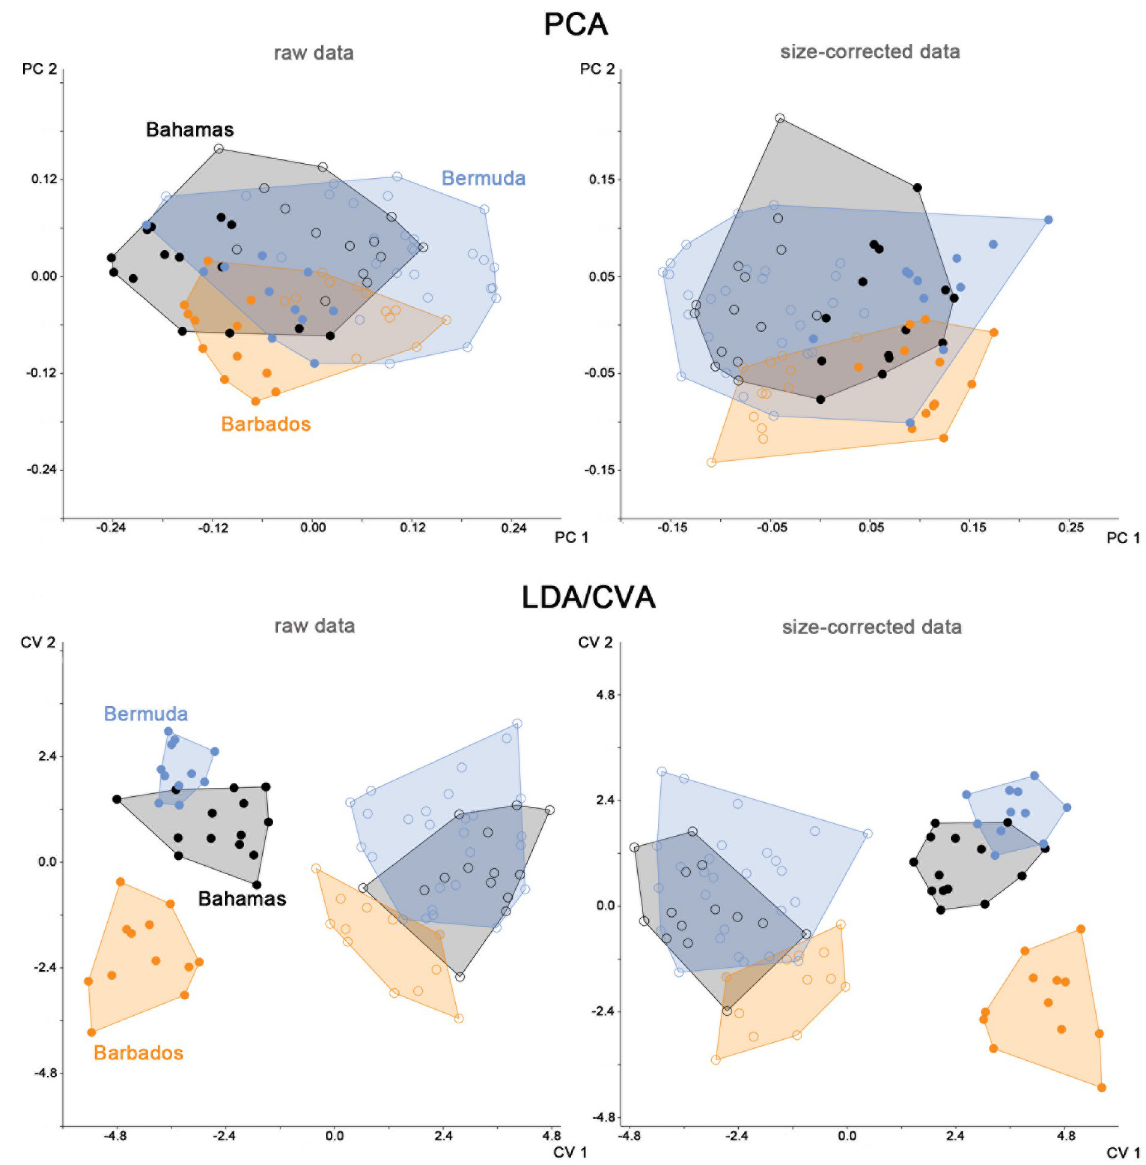
Fig 2. Graph showing results of morphometric analyses of three different populations of Fortuynia atlantica . Upper row PCA graphs, lower row LDA/CVA graphs with males and females segregated. Colors refer to geographic locations, full circles represent male and empty circles represent female